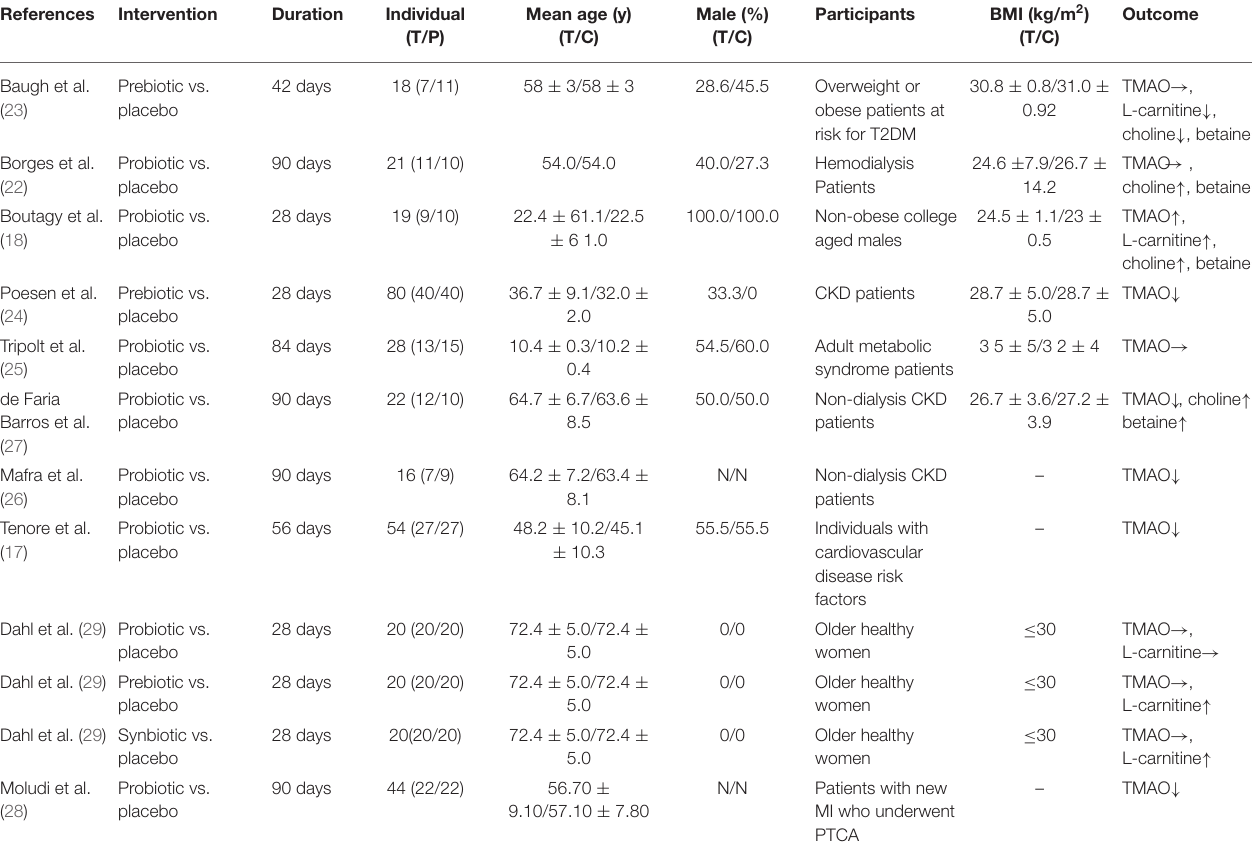
TABLE 1 | Characteristics of the trials included in this meta-analysis.